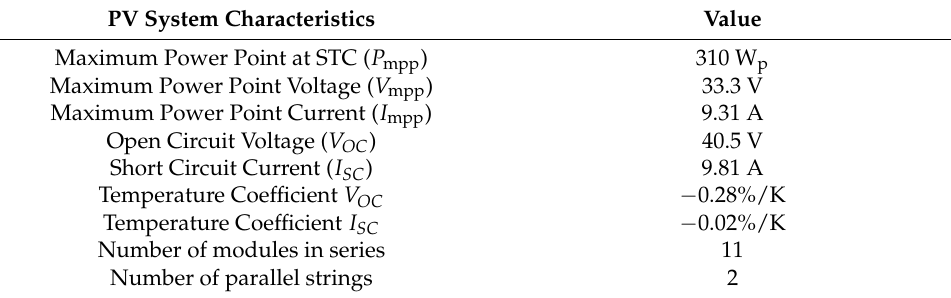
Table 1. PV system characteristics (Type: SMA310M-6X10DW).